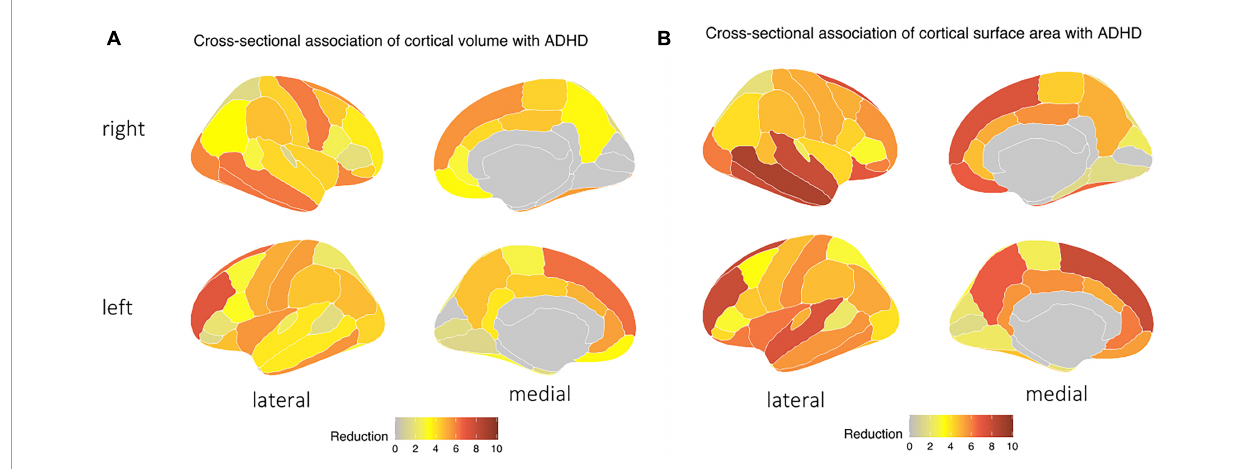
FIGURE2 Children with ADHD tend to have a decrease in both in (A) cortical surface area and (B) cortical volume, particularly in the temporal and frontal lobes, as indicated by the blue area – independent of age, biological sex, race, handedness, and highest parental education as a marker of socioeconomic status, and after correction for multiple